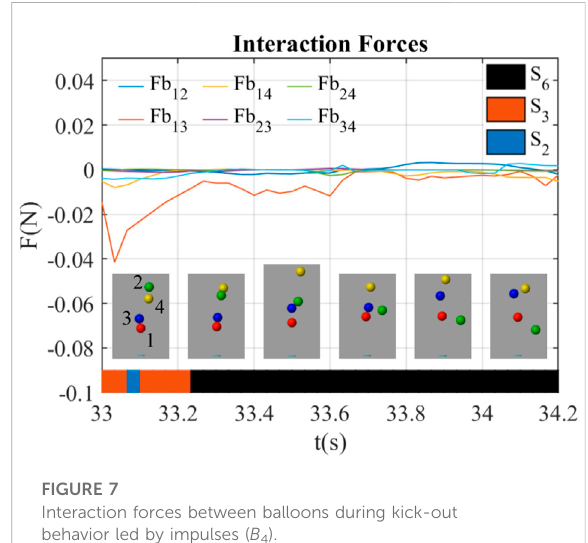
FIGURE 7 Interaction forces between balloons during kick-out behavior led by impulses ( B 4